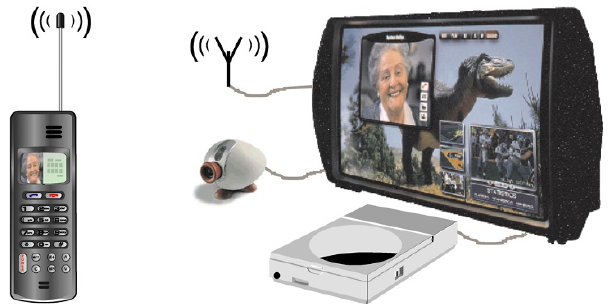
Figure 1: Multimedia applications shown on di ff erent devices sharing the available resources.